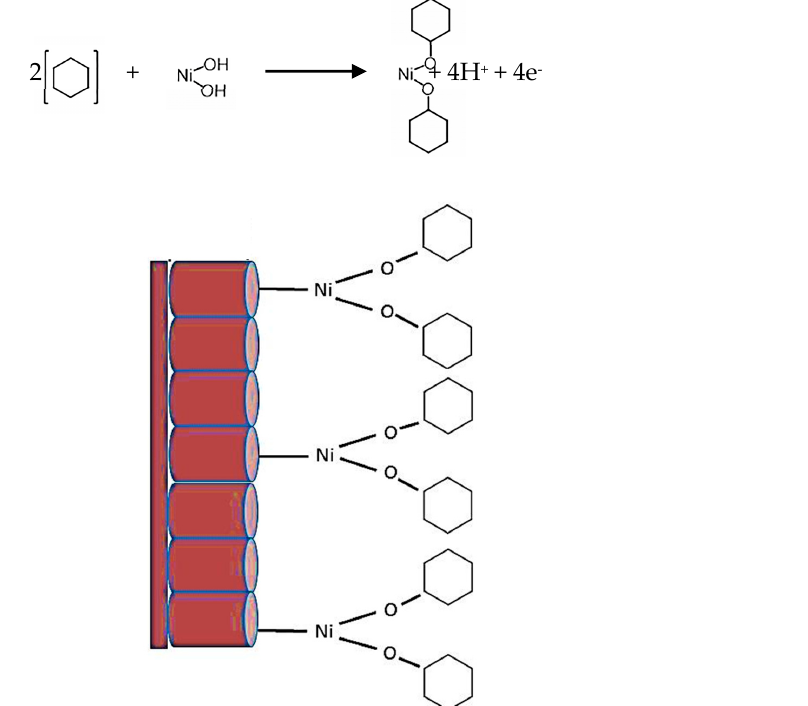
Figure 10. Schematic diagram showing the formation of the nickel cyclohexyl complex on the TNA . The high current response, indicative of a strong interaction between nickel and cyclohexane, is well corroborated by the reaction mechanism shown above. Not only does the efficiency of binding follow a 1:2 ratio of nickel to cyclohexane, but the unique characteristics of TiO 2 nanotubes in electron transfer and atmospheric oxygen adsorption make it a suitable and highly favorable reaction. In the case of the former, as reported by Bhattacharya et al . [30], the structure of these nanotubes provides not only stability and increased surface area of the interaction between the metal ions and cyclohexane but the tubular structure also enables greater electron transfer between the biomarker and the metal ions during the oxidative interaction with minimal losses. As to the adsorption of atmospheric oxygen, this characteristic of TiO 2 is vital in the steps following the synthesis of this radical complex that allows for the formation of the intermediates mentioned above [37,38]. This is supported by the studies of Ide et al . [38] that reports on the importance of the superoxide anion that plays a role in the formation of cyclohexanone and cyclohexanol. TiO 2 generates this superoxide anion reaction. The following equations reported by Bhattacharya et al . [30] show how this may be possible: